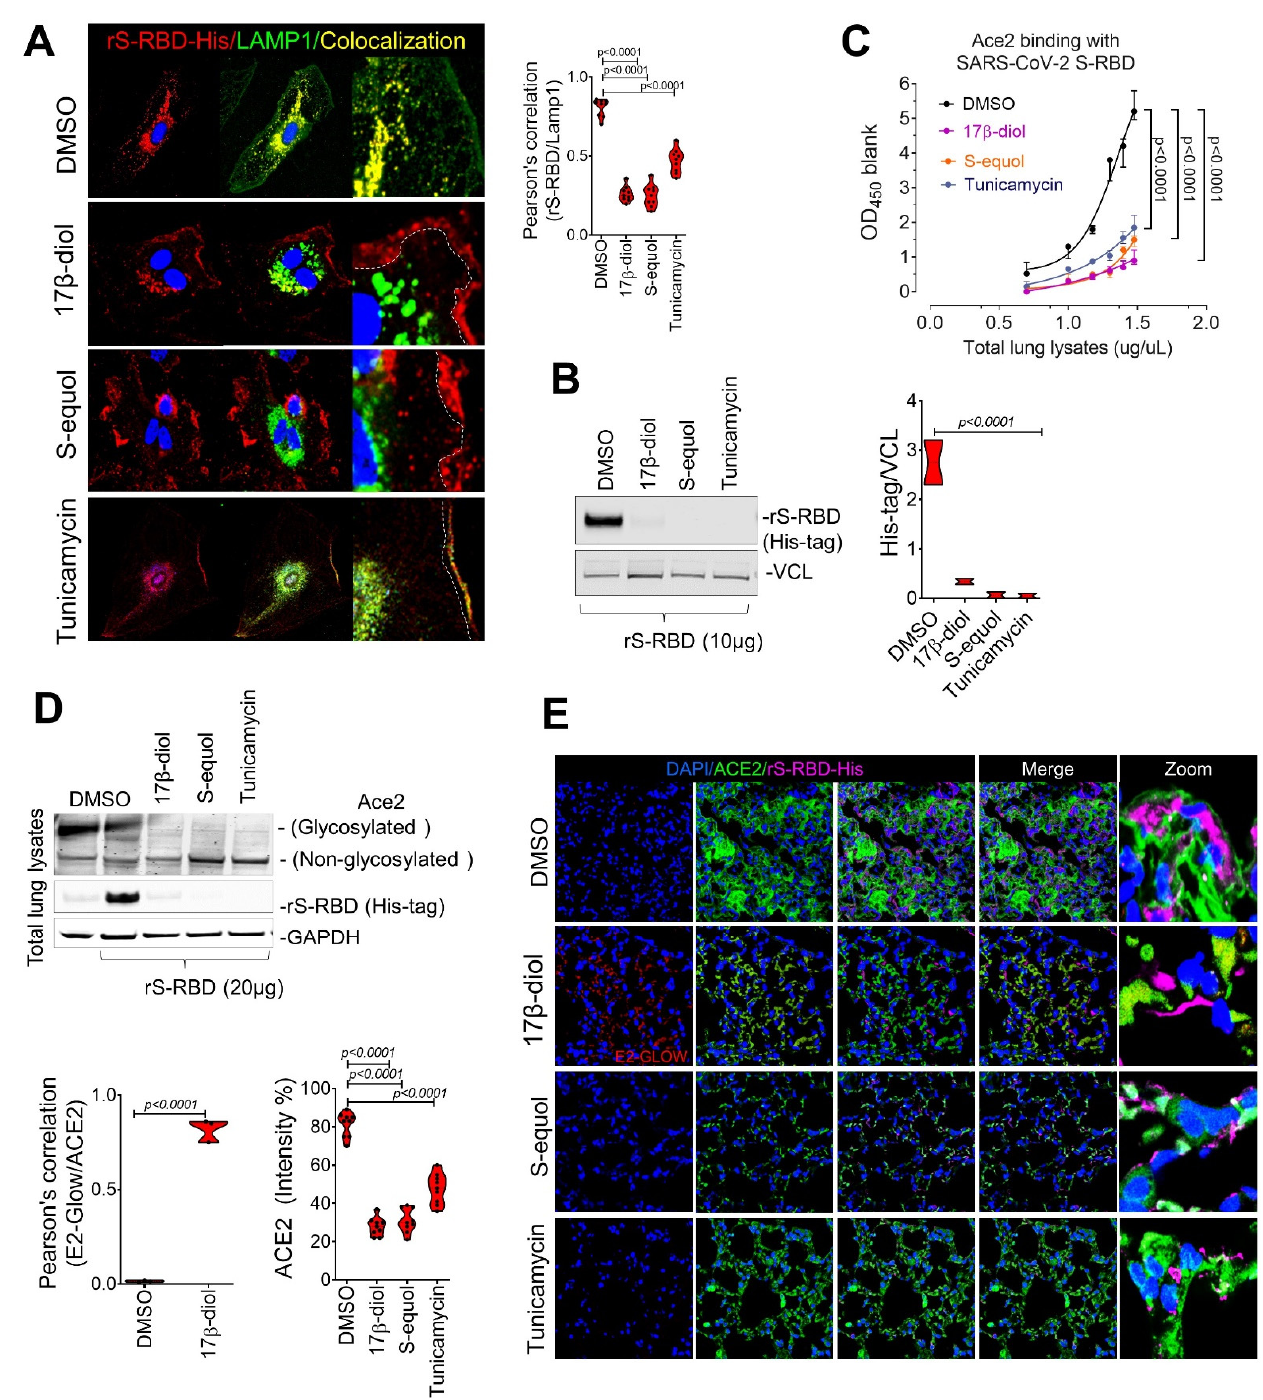
Figure 5. Estrogens block SARS-CoV-2 S protein uptake in the respiratory tract in vivo. ( A , B ) Immunofluorescence analysis of S-RBD entry into HUVECs pretreated estrogens (17 β -diol or S-equol) or Tunicamycin (glycosylation inhibitor) followed by treatment with 10 µ g/mL of recombinant S-RBD (red) demonstrate that all 3 treatments cells reduced entry of S-RBD entry into cells via a reduction in Ace2 internalization as shown by colocalization with LAMP1 (green) and immunoblot. ( C ) ELISA-based binding assay using lung protein lysates from male mice (K18-ACE2) treated with 17 β -diol (0.3 µ M) or S-equol (1 µ M) or Tunicamycin (1 mg/Kg) shows reduced SARS-CoV-2 S protein affinity for the Ace2 receptor. ( D ) Immunoblot shows the glycosylation levels of Ace2 from total lung lysate in mice treated with estrogens or Tunicamycin. ( E ) Immunofluorescence of Ace2 (green) and RBD (magenta) in lungs from lysates from male mice (K18-ACE2) treated with estrogens or